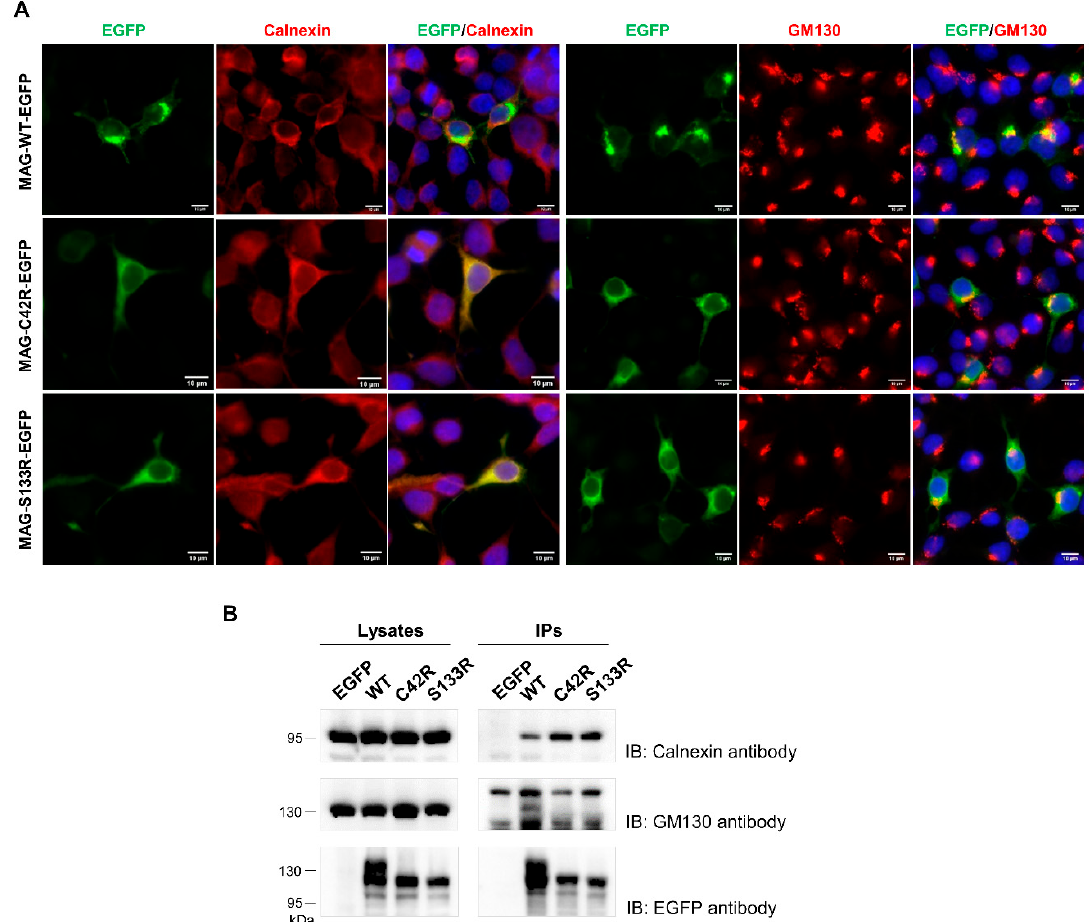
Figure 3. MAG-C42R has an altered subcellular localization. ( A ) The localization of EGFP-tagged MAG clones in HEK293T cells. EGFP was directly visualized. The presence of MAG in the endoplasmic reticulum and Golgi complex was analyzed by probing cells with anti-calnexin and anti-GM130 antibodies, respectively, both detected with Alexa Fluor 568-conjugated secondary antibodies (red). DNA was stained with Hoechst 33342 (blue). Photographs were acquired using a Zeiss Axio Imager Z1 microscope. Bars: 10 µm. ( B ) The co-immunoprecipitation of EGFP-tagged MAG clones with endogenous calnexin and GM130 in HEK293T cells. Cell lysates were immunoprecipitated with anti-GFP antibody. The immunoprecipitates were subjected to immunoblotting with anti-GM130 antibody, then stripped and reprobed with anti-calnexin antibody, followed by stripping and reprobing with anti-EGFP antibody. The same methodology was applied to whole cell lysates. Calnexin and GM130 immunoblotting figures have different exposure times (original blots are presented in Figure S2).